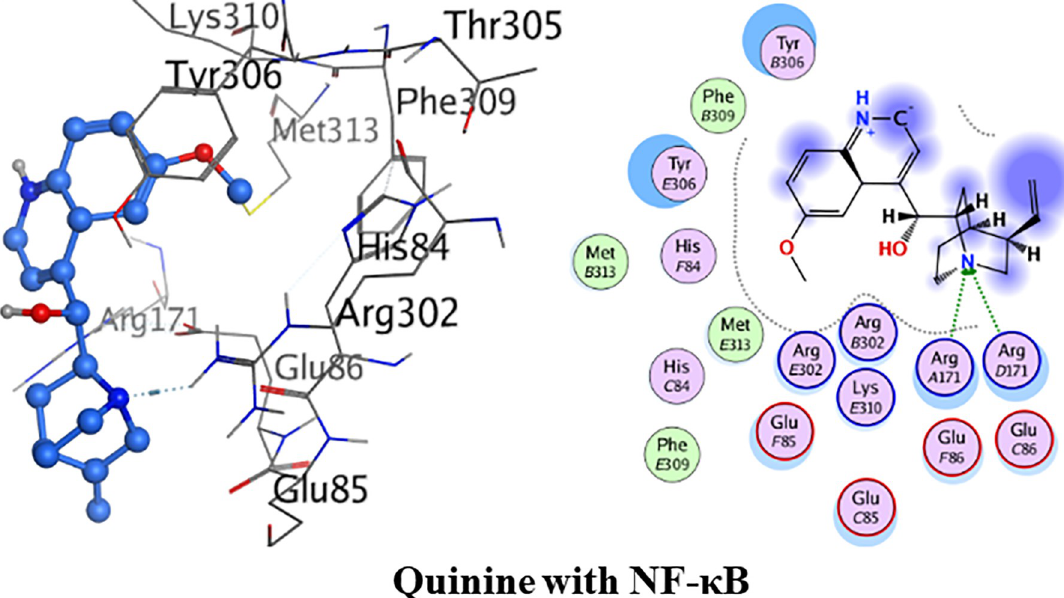
Fig 10. 3D and 2D interactions of quinine with active site of nuclear factor kappa B (NF- κ